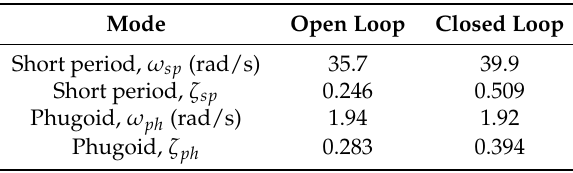
Table 12. Open loop and closed loop longitudinal modes of MAV.